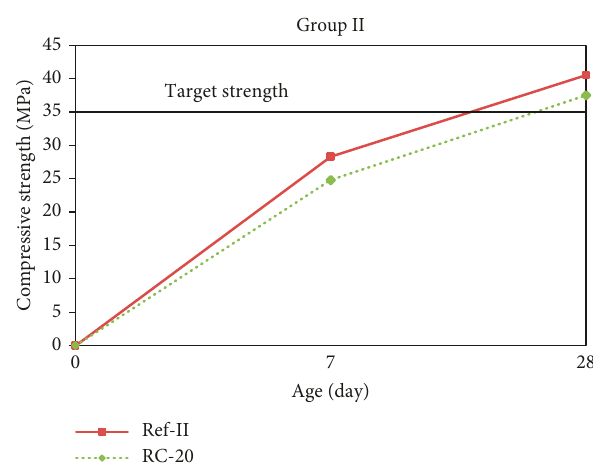
Figure 4: Compressive strength of the concrete specimens cate- gorized in Group